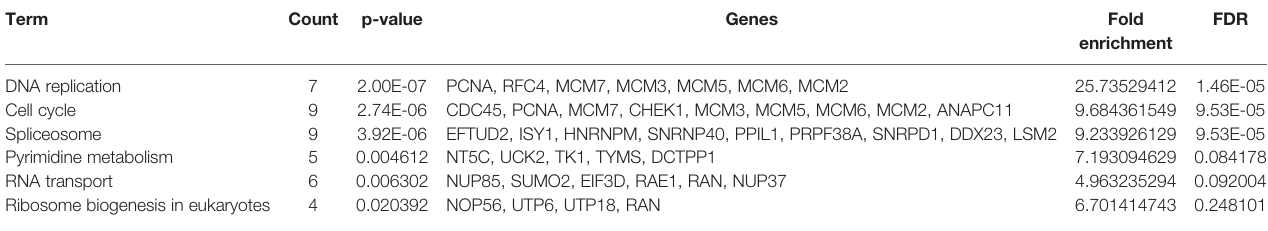
TABLE 1 | KEGG analysis of the 104 common